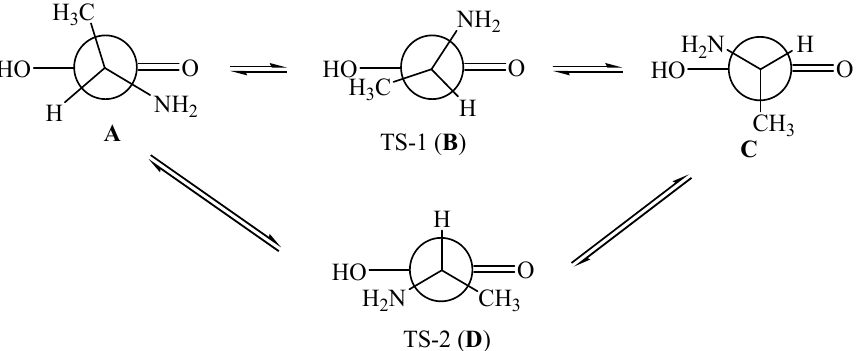
Figure 18. Preferred conformation of S-1-fluoroethanol inside SWCNTs. Adapted with modification [257].